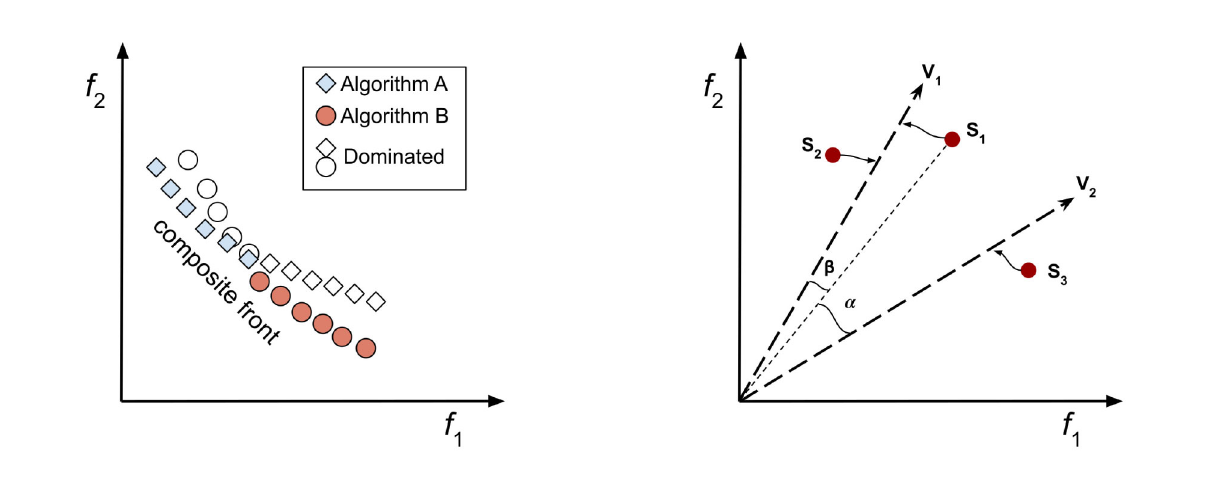
Fig. 1 Division of the PF internally performed in ADM-II to CF , which is obtained as the number of nondominated solutions each method has contributed to build/extend the composite front along the